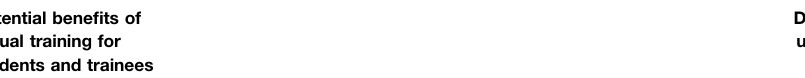
TABLE 1 | Potential long term pros and cons of virtual learning for pathology. Potential bene fi ts of virtual training for students and